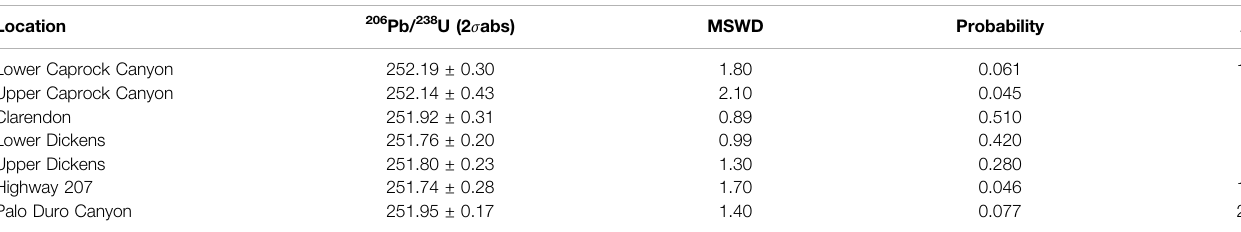
TABLE 2 | Summary of U-Pb zircon isotopic age results (in MA). Location